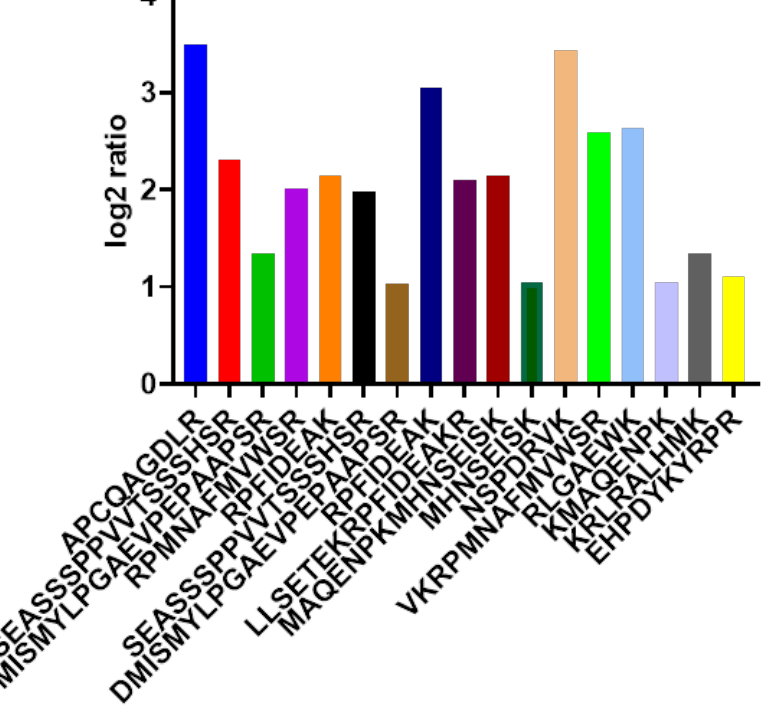
Figure 2. iTRAQ ratios of the tryptic peptides identified and analyzed using Breast cancer Mass Spectrometry data.